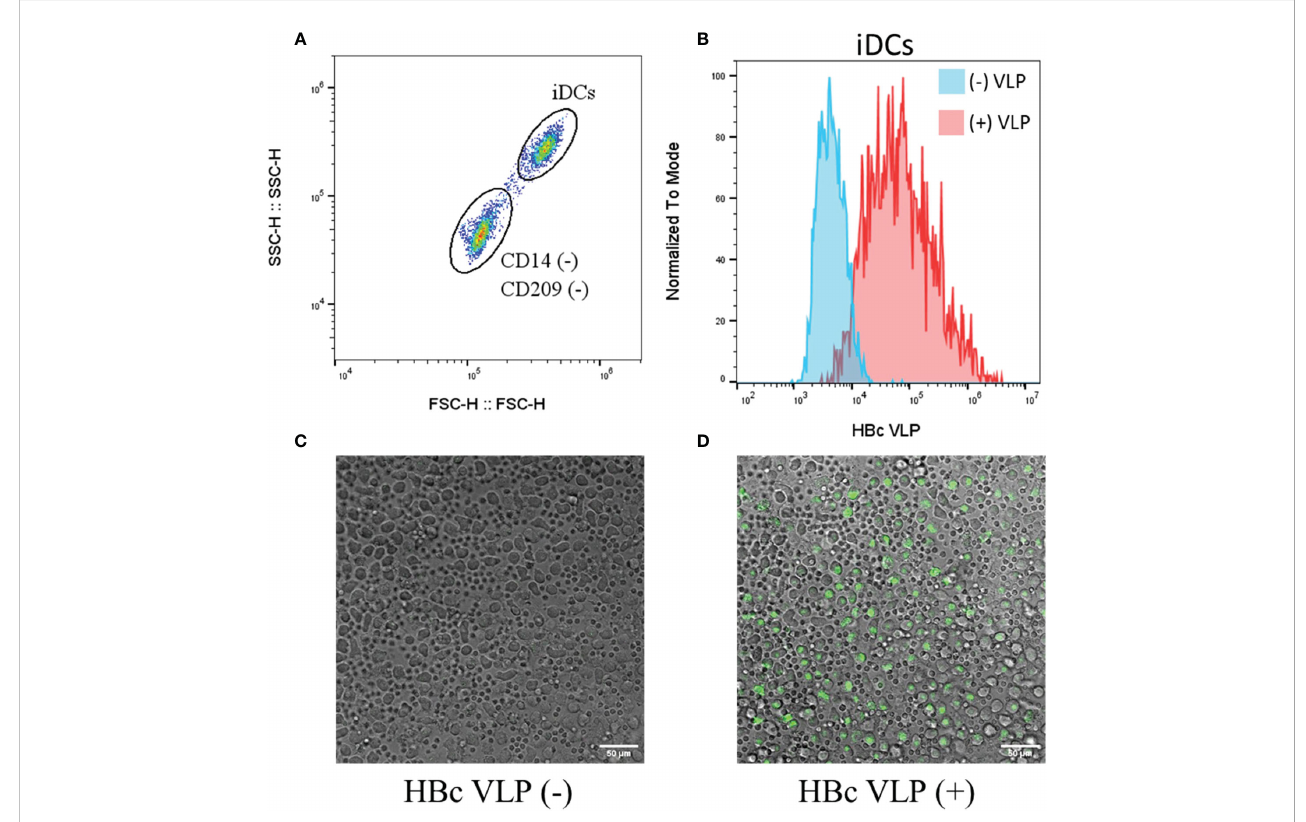
FIGURE 7 Recognition and endocytosis of fl uorescently labelled HBc VLPs by human iDCs. Human iDCs were differentiated from isolated monocytes and incubated with a fl uorescently labelled HBc VLP (A) Flow cytometry analysis of the cells after iDC differentiation, showing the two cell populations obtained (B) Flow cytometry analysis for the iDCs non-incubated (blue) and incubated (red) with fl uorescent HBc VLPs (C) Fluorescent confocal imaging shows the composite fi elds of non-incubated cells and (D) fl uorescent HBc VLP-incubated cells. HBc, hepatitis-B core antigen VLP; FSC, forward scatter; SSC, Side scatter; iDCs, immature dendritic